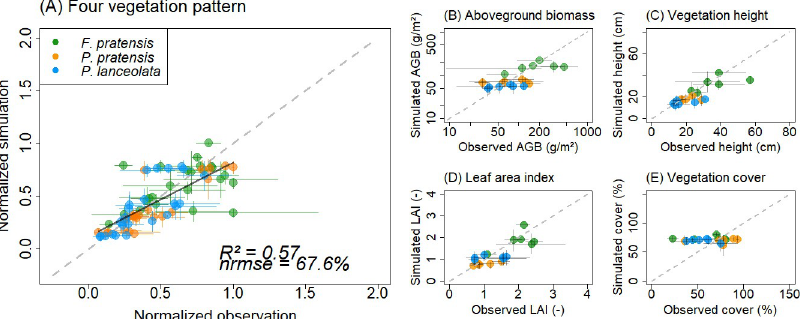
Fig 2. Comparison of observed and simulated patterns in terms of aboveground biomass, vegetation height, leaf area index and vegetation cover for three monocultures. Each dot reflects a yearly value. Colors mark results for the different species. In (A) all compared patterns for the three species are combined. Different patterns are normalized by the maximum value (of observations and simulations for all species). The black solid line shows the linear regression line for which the R 2 and nrmse is displayed. In (B-E) each pattern is displayed without normalization. Note that axes for AGB are logarithmic.